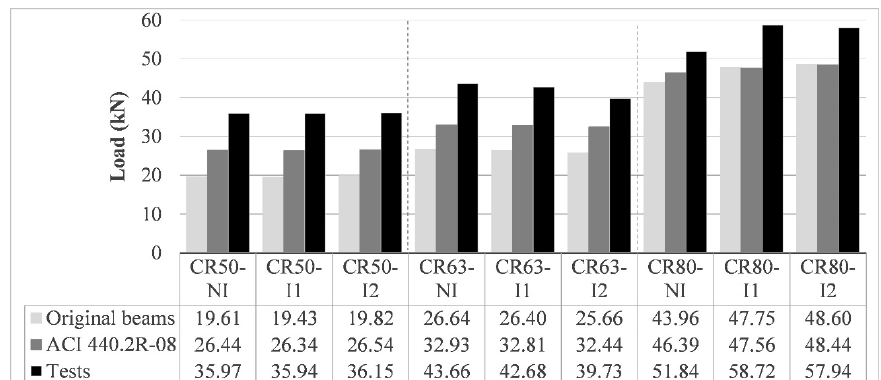
Figure 15. Ultimate loads obtained for the original beams based on design specifications in the ACI 440.2R [8] and through tests. Load (kN) represents the sum of the loads (2 P ) applied to the